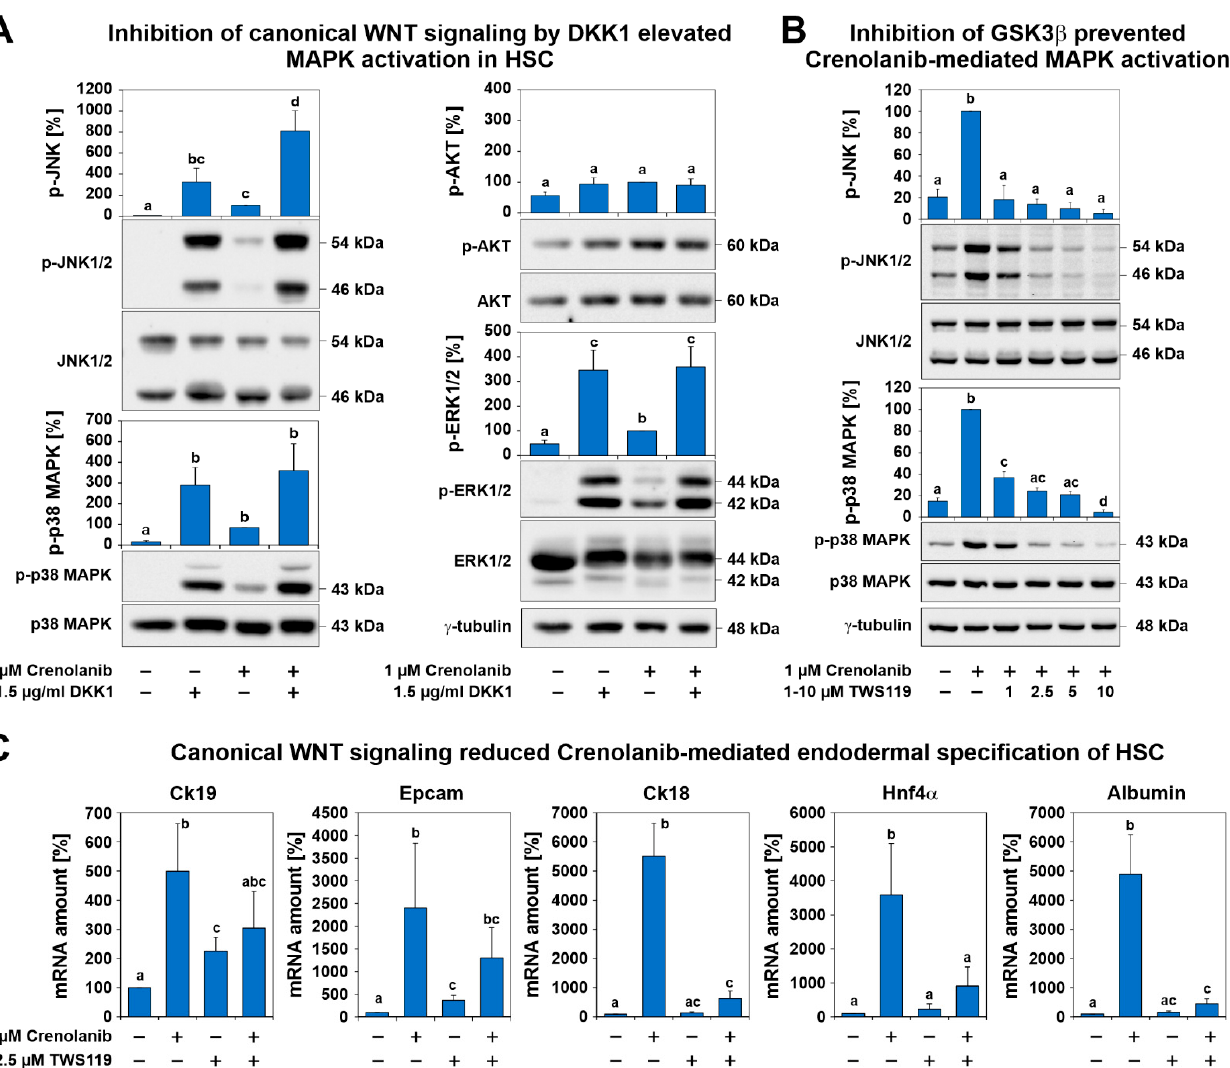
Figure 7. Canonical WNT signaling prevented the activation of signaling cascades associated with proliferation and differentiation, supporting quiescence in HSC. ( A ) Culture-activated HSC were treated with 1.5 µg/mL dickkopf 1(DDK1) for 1 h prior to 1 µM Crenolanib administration. The inhibition of canonical WNT signaling by DDK1 resulted in the increased phosphorylation of p38 MAPK, JNK, and ERK1/2, as assessed by Western blot analysis, even in the absence of Crenolanib, whereas AKT signaling was weakly affected. Crenolanib significantly elevated the phosphorylation of JNK ( n = 3; p < 0.05). ( B ) HSC were pretreated with the GSK3 β inhibitor TWS119, which reduces β -catenin degradation and promotes canonical WNT signaling. This approach significantly reduced the activation of p38 MAPK and JNK in response to Crenolanib. The results of the Crenolanib-treated group were set to 100% in the densitometry analysis of the Western blots ( n = 3). ( C ) The expression analysis of HSC treated with Crenolanib for 7 days in the presence or absence of 2.5 µM TWS119. The Crenolanib-induced expression of hepatocyte markers Ck18 , Hnf4 α , and albumin was inhibited by TWS119, as measured by qPCR. The progenitor markers Epcam and Ck19 were only slightly suppressed ( n = 4; p < 0.05; significant differences are indicated by different letters).